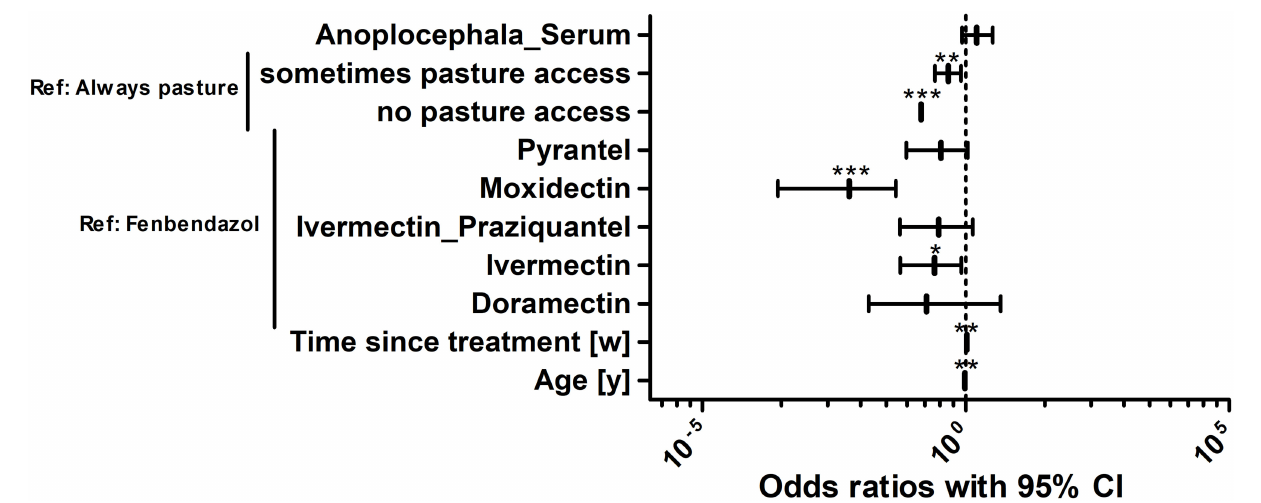
FIGURE 6 | Risk factor analysis for the odds of horses in the study population to be positive for strongyle eggs. Risk factors for the odds to be positive or negative for strongyle eggs were determined using logistic regression analysis. Anoplocephala_Serum, positive in the Anoplocephala serum ELISA; Drugs refer to the drug used for the last treatment; Time since treatment represents the time since the last anthelmintic treatment in weeks [w]. The age refers to the age of the animals in years [y]. The age of horses was rounded into whole years. For foals and yearlings, the age was converted from months to years by dividing the month measurement by